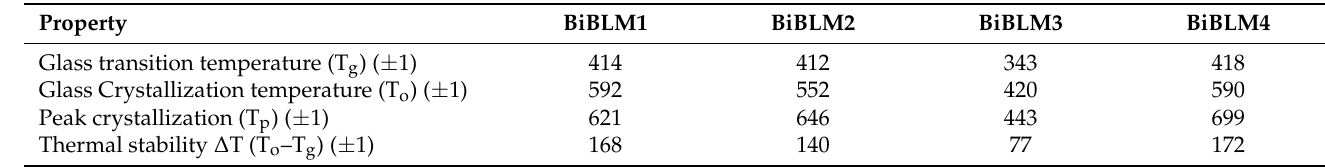
Table 2. DSC parameters of BiBLM glasses.